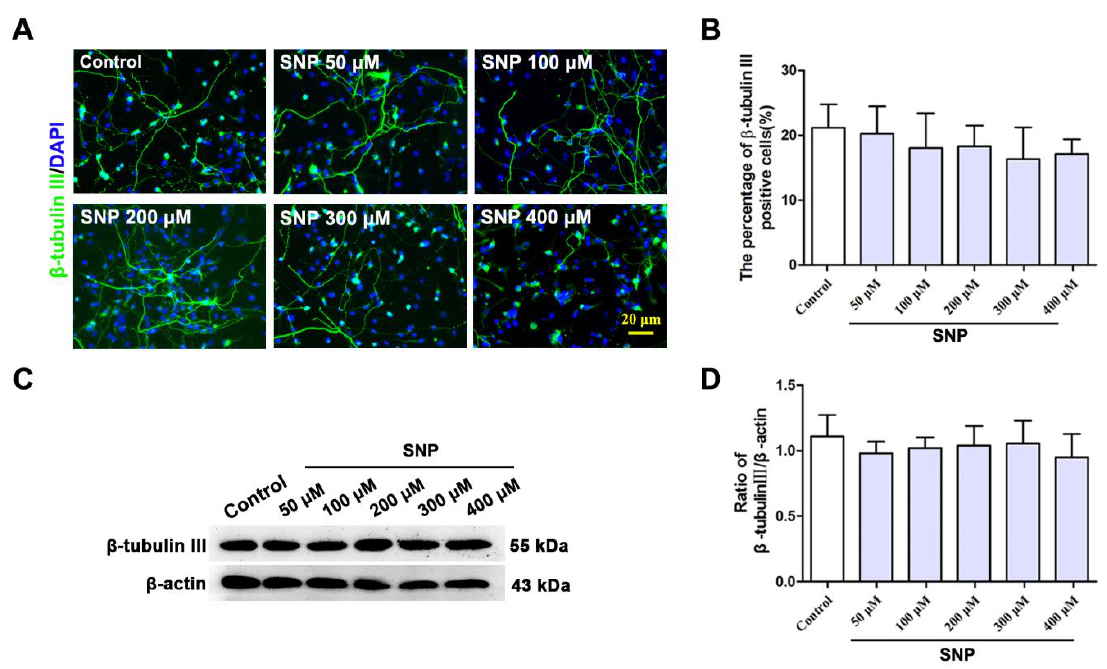
Figure 4. The effects of SNP on the differentiation of NSCs. ( A ) Immunocytochemistry staining of β -tubulin III positive cells. Scale bar = 50 μm. ( B ) Data analysis of the percentage of β -tubulin III positive cells, n = 5. ( C ) The expression of β -tubulin III was tested by Western blots. ( D ) Data analysis of the ratio of β -tubulin III/β -actin. All data were obtained from three independent experiments and three replicates for every experiment. The values are the mean ± SD and were analyzed via a one-way ANOVA test, n = 3.